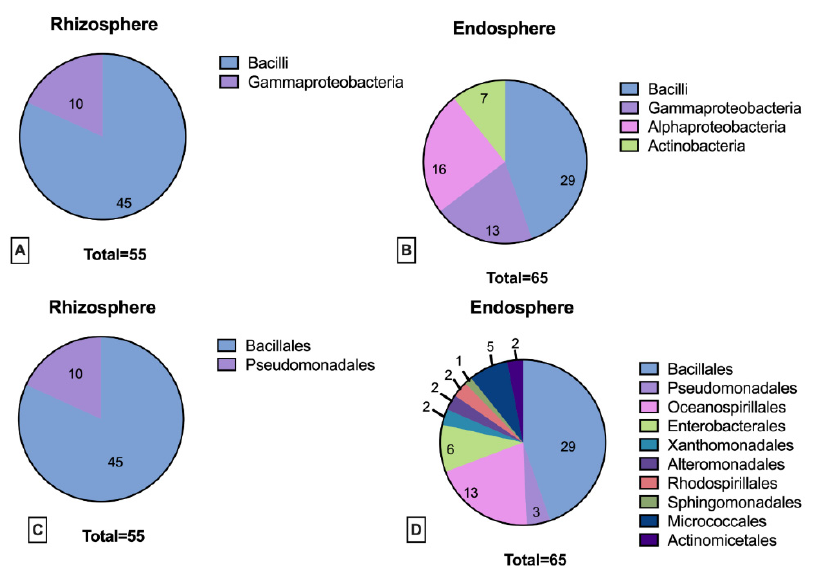
Figure A2. Total taxonomic distribution of the isolates from the endosphere and rhizosphere of Salicornia ramosissima at class ( A , B ) and order ( C , D ) taxonomic levels.